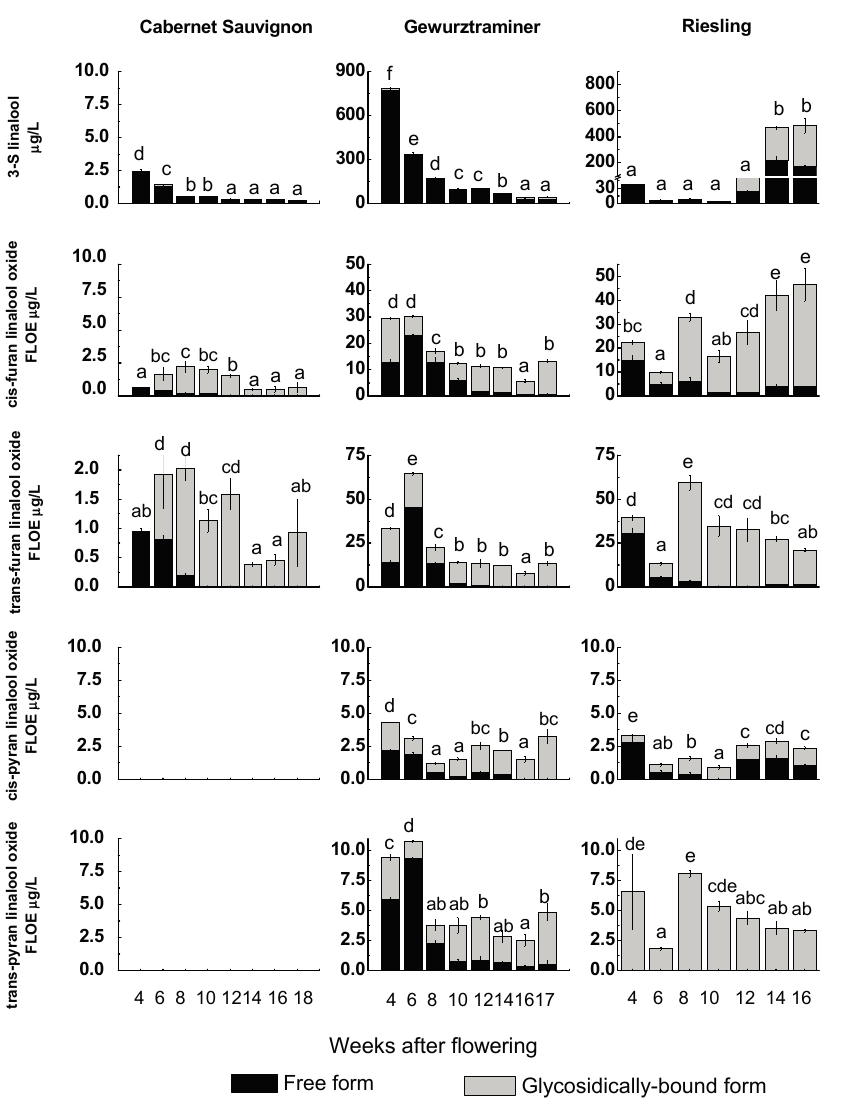
Figure 5. Profiling of linalool and its related oxide in developing grape berries. Each data point is the mean of three values and their standard deviation. Different letters (a–f) indicate that the concentrations of the compound had significantly difference at p < 0.05